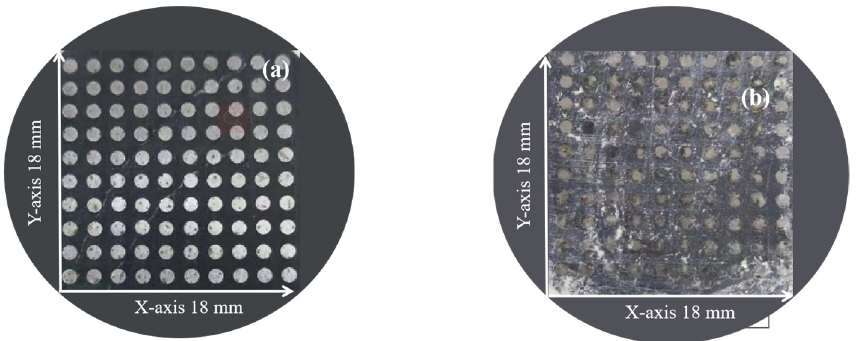
Figure 7. Optical picture of WBE at pH = 3.10: ( a ) bare electrode, ( b ) S8 − coated electrode.